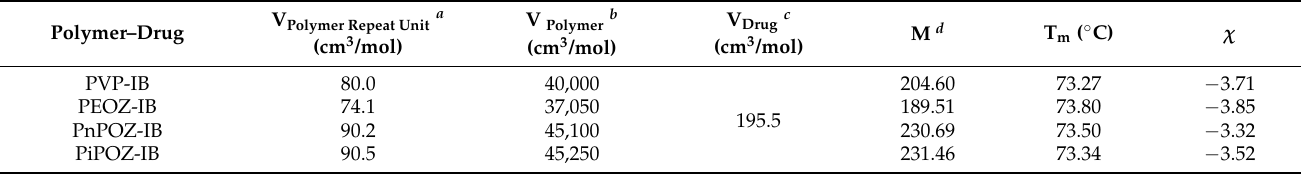
Table 3. Flory–Huggins interaction parameters of polymer–IB solid dispersion systems at the molar ratio of 0.3:1.